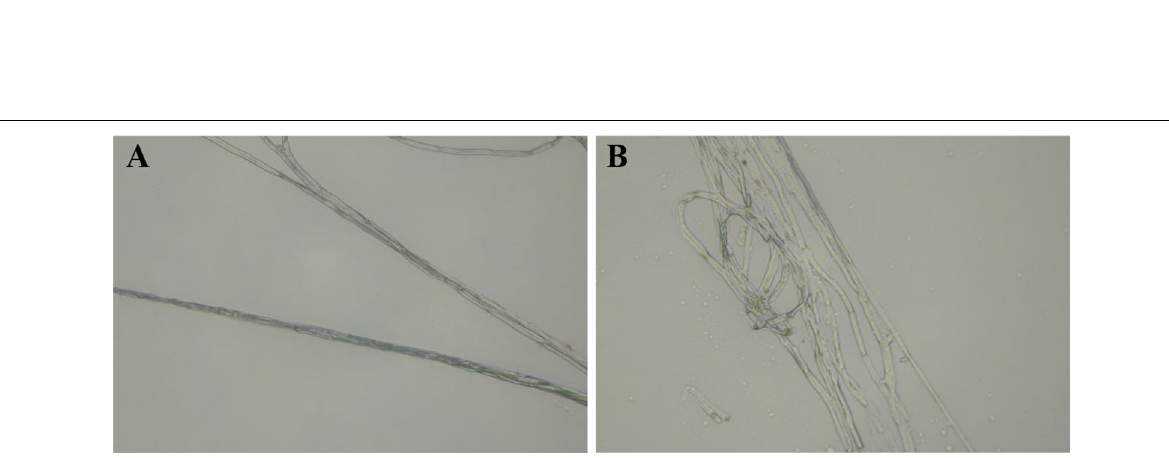
Fig. 6 Morphology of FOC TR4 hyphae under electron microscope. A Healthy FOC TR4 hyphae have smooth surface and uniform thickness. B Gxun-6 antagonised the knotting and breaking of